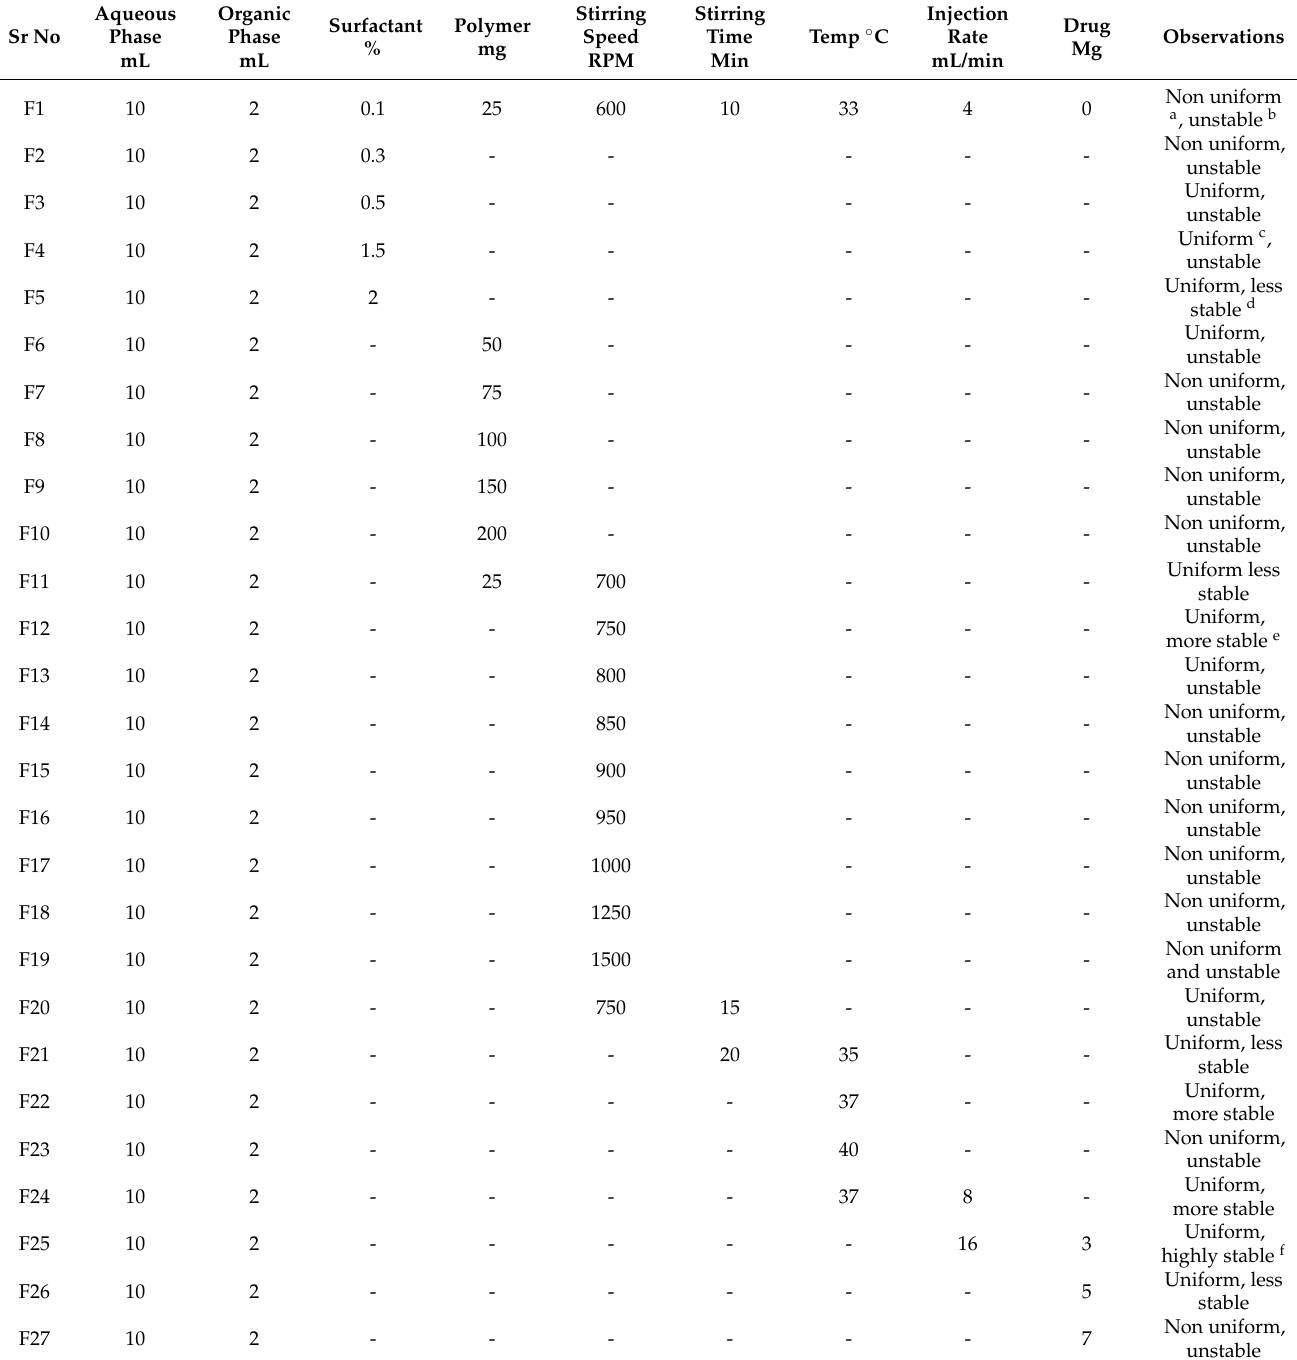
Table 1. Composition of various formulations in the optimization of